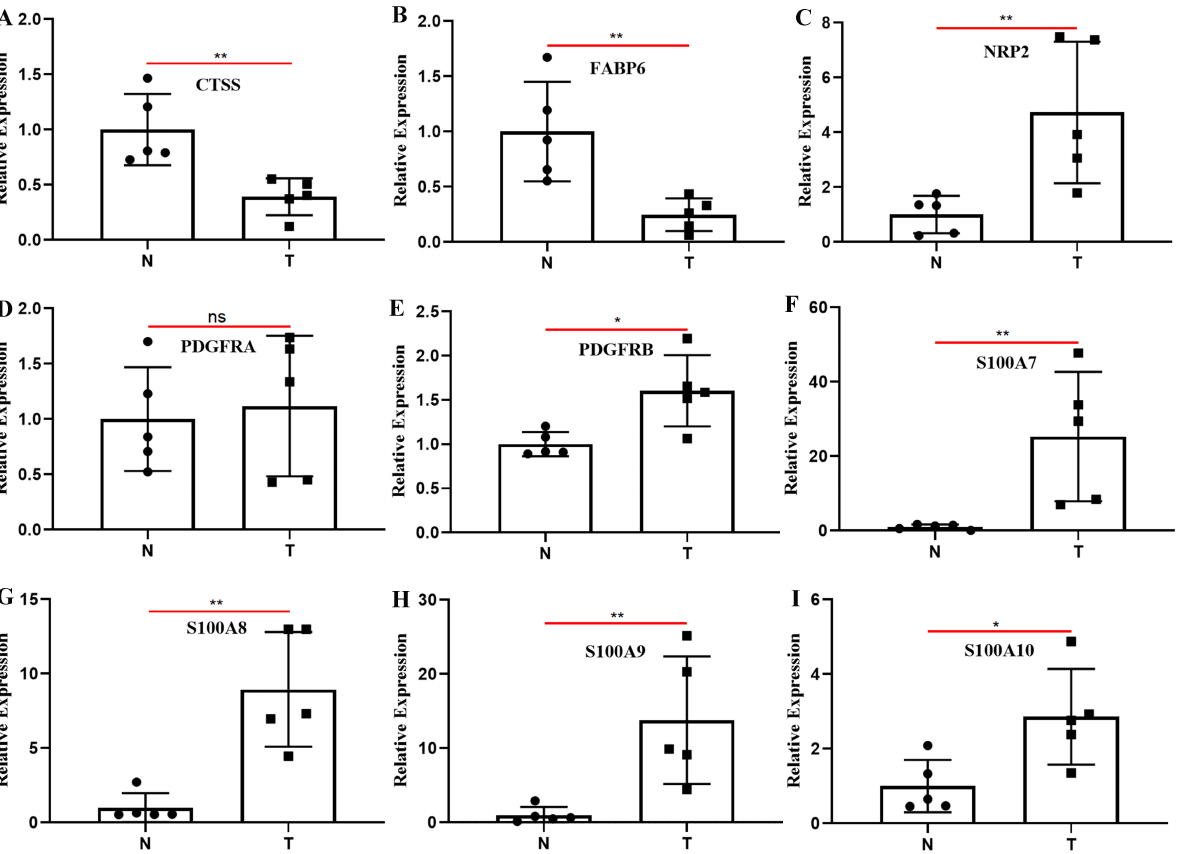
Figure 9. Clinical samples were used to detect the differences in the expression of nine genes used to construct IRPM between BLCA and adjacent normal tissues through RT-qPCR. ( A ) CTSS; ( B ) FABP6; ( C ) NRP2; ( D ) PDGFRA; ( E ) PDGFRB; ( F ) S100A7; ( G ) S100A8; ( H ) S100A9; ( I ) S100A10. T: BLCA tissues; N: adjacent normal tissues; * p < 0.05, ** p < 0.01; ns: the difference was not statistically